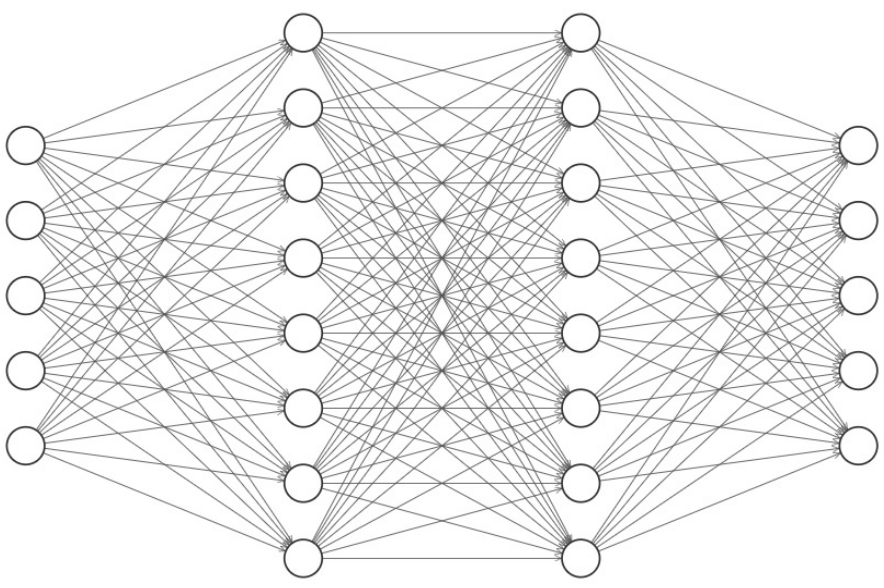
Figure 1. System Model.